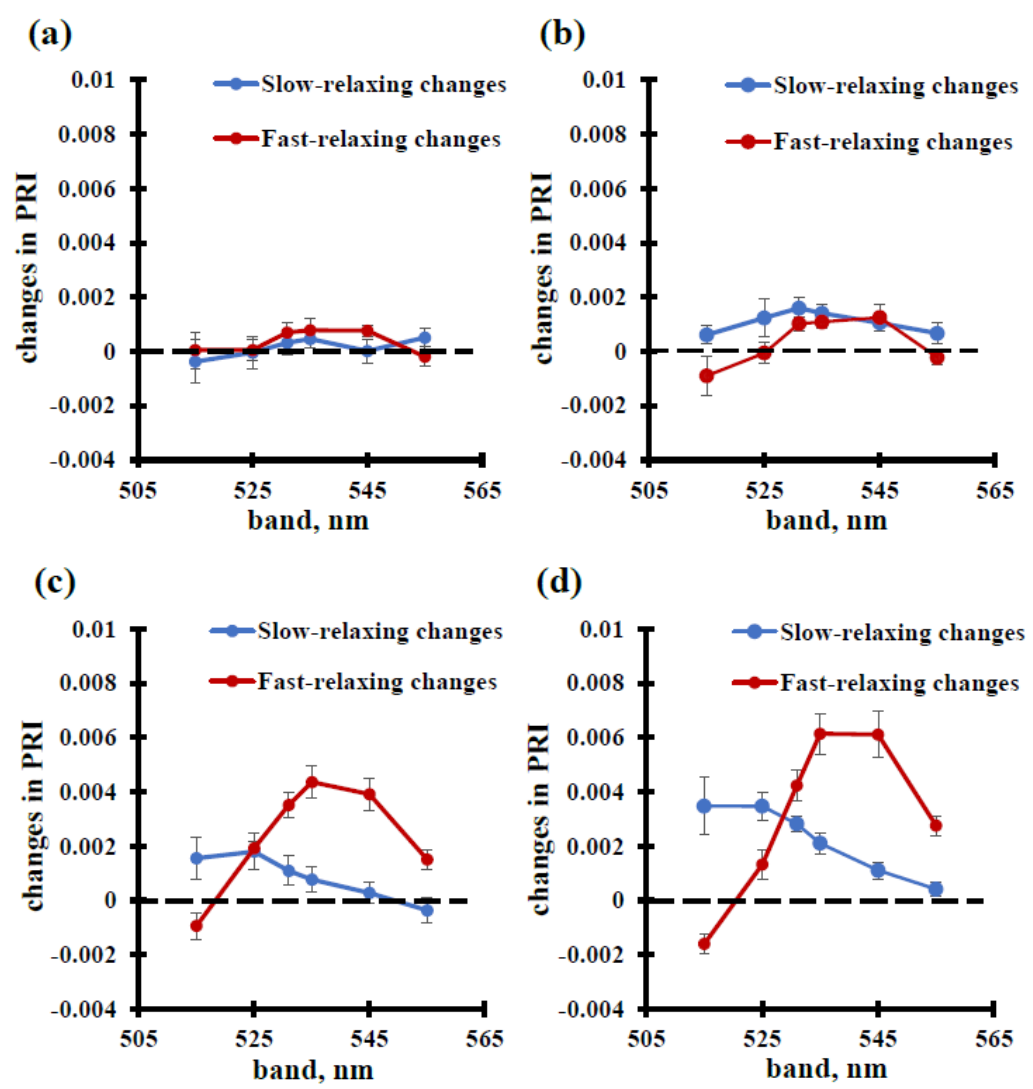
Figure 8. Dependences of the magnitudes of the slow- and fast-relaxing components of the PRIs on the spectral band of the reflected light, which was used for the calculation of the photochemical reflectance index (band) under different intensities of plant illuminations by actinic light ( n = 6). (a) The magnitudes under 131 µmol m -2 s -1 ; (b) the magnitudes under 344 µmol m -2 s -1 ; (c) the magnitudes under 830 µmol m -2 s -1 ; (d) the magnitudes under 1599 µmol m -2 s -1 .